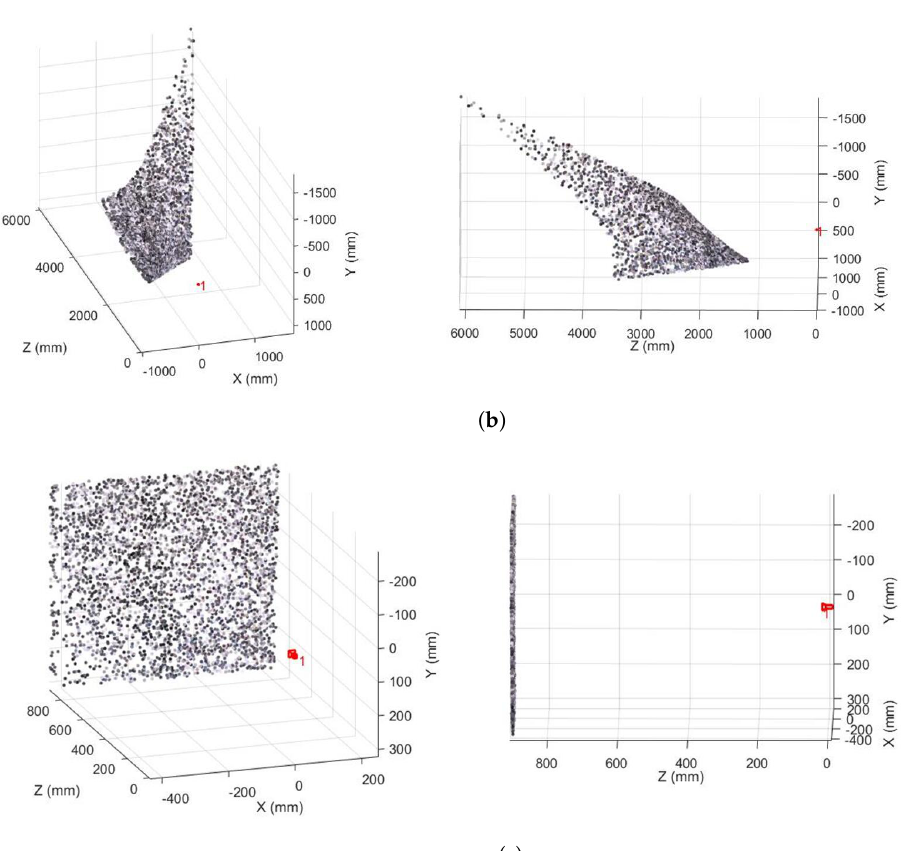
Figure 14. 3D reconstruction of a flat plate using non-degenerate technique (SfM) and proposed degenerate technique. ( a ) An image of the flat plate sticked with mimic road pattern. ( b ) 3D reconstruction of flat surface in (a) using traditional SfM. The left image shows the front view of the reconstructed 3D points and the right image shows the left view. ( c ) 3D reconstruction of flat surface in (a) using the proposed technique. The left image shows the front view of the reconstructed 3D points and the right image shows the left view.